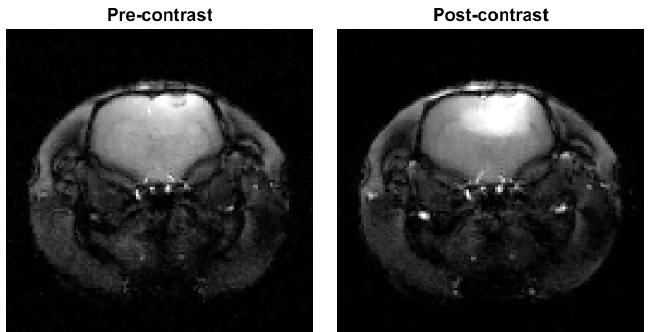
Figure 2. Cartesian gradient-echo pulse sequence full data reconstructions with spatial total variation (TV) regularization from before and after contrast injection used as a reference. The two images have the same adjusted color